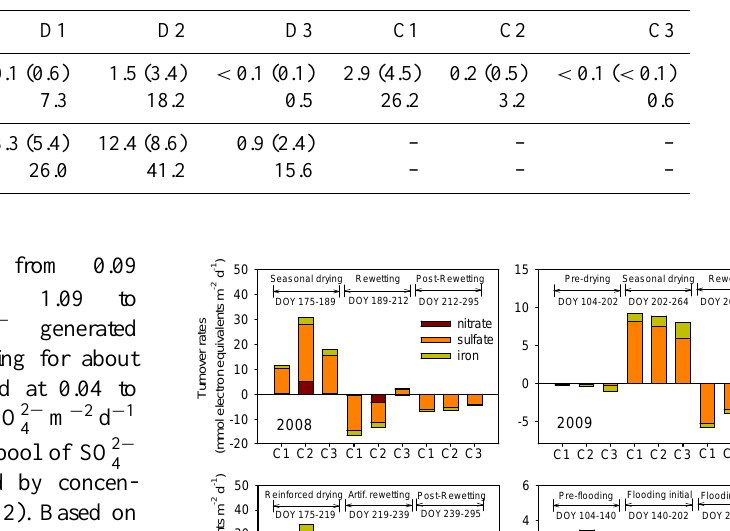
Table 2. Concentrations of sulfides (µmolL − 1 ) in control (C) and manipulated (D) plots illustrating the effects of flooding. Values show mean with one standard deviation (SD) and maximum concentrations. No or lower values were observed during drying.